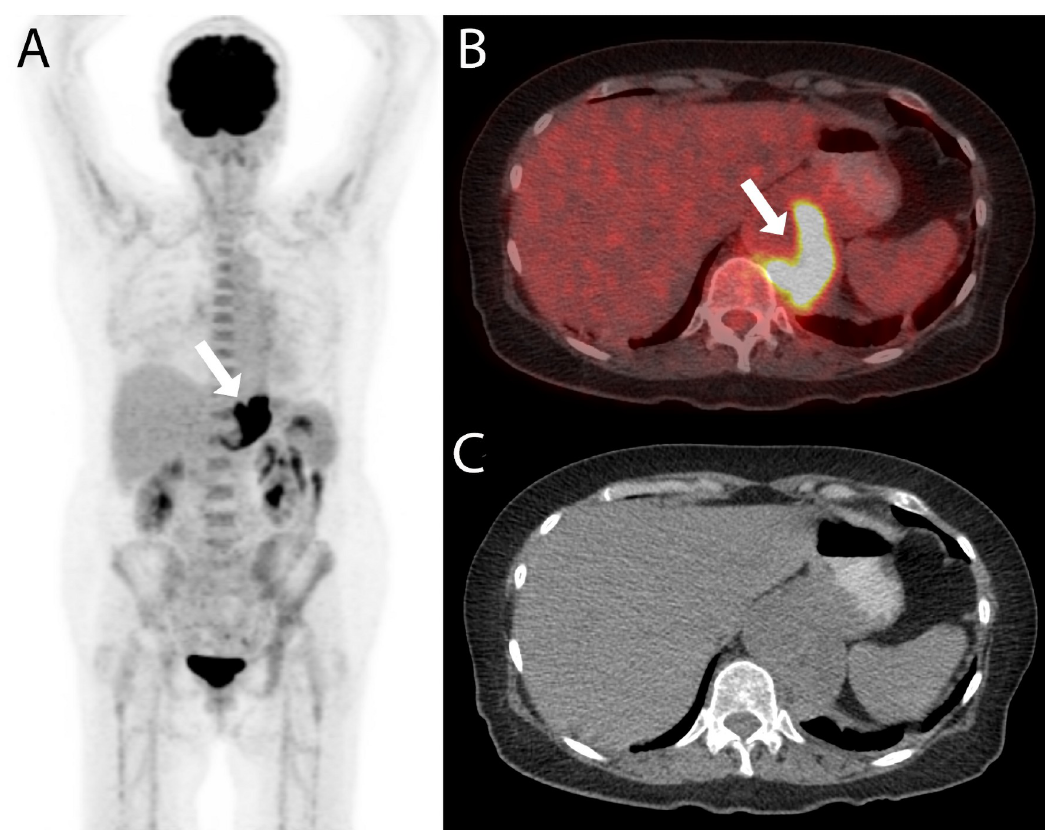
Fig 3. PET/CT with confirmed impact on management. A 71-year old woman was referred for PET/CT for staging of gastric cancer and with the question for an infectious aneurysm. The PET/CT examination (A: maximum intensity reconstruction, B: fused axial PET/CT image, and C: axial non-enhanced CT image) showed a FDG-avid mass adjacent to the abdominal aorta (white arrows in A and B). Both readers correctly rated the finding to be an infectious aneurysm; no gastric cancer was detected. The diagnosis was confirmed after biopsy (MAA caused by Coxiella burnetii ) and the patient was treated with endovascular aortic repair and partial gastrectomy and lymphadenectomy. The patient was treated with antibiotics for 784 days and did not show any sign of recurrence at the last clinical visit 293 days after the end of antimicrobial